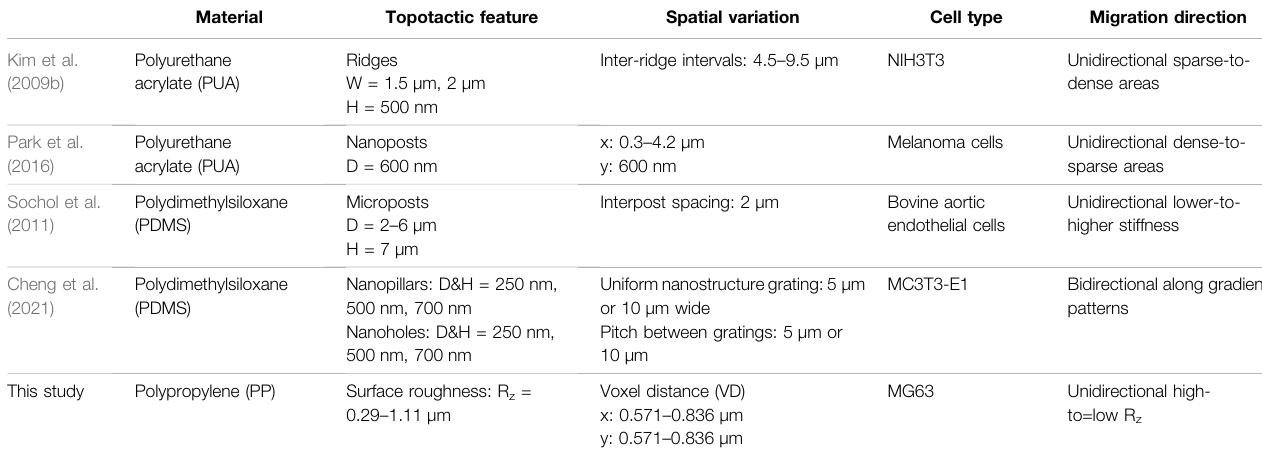
TABLE 1 | Comparison of topographic patterns for